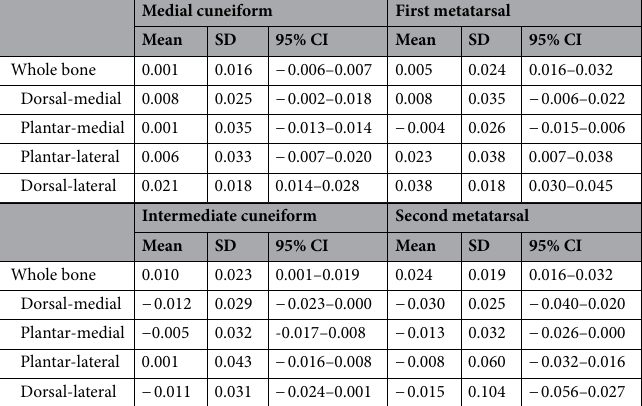
1st TMT joint 2nd TMT joint Mean SD 95%